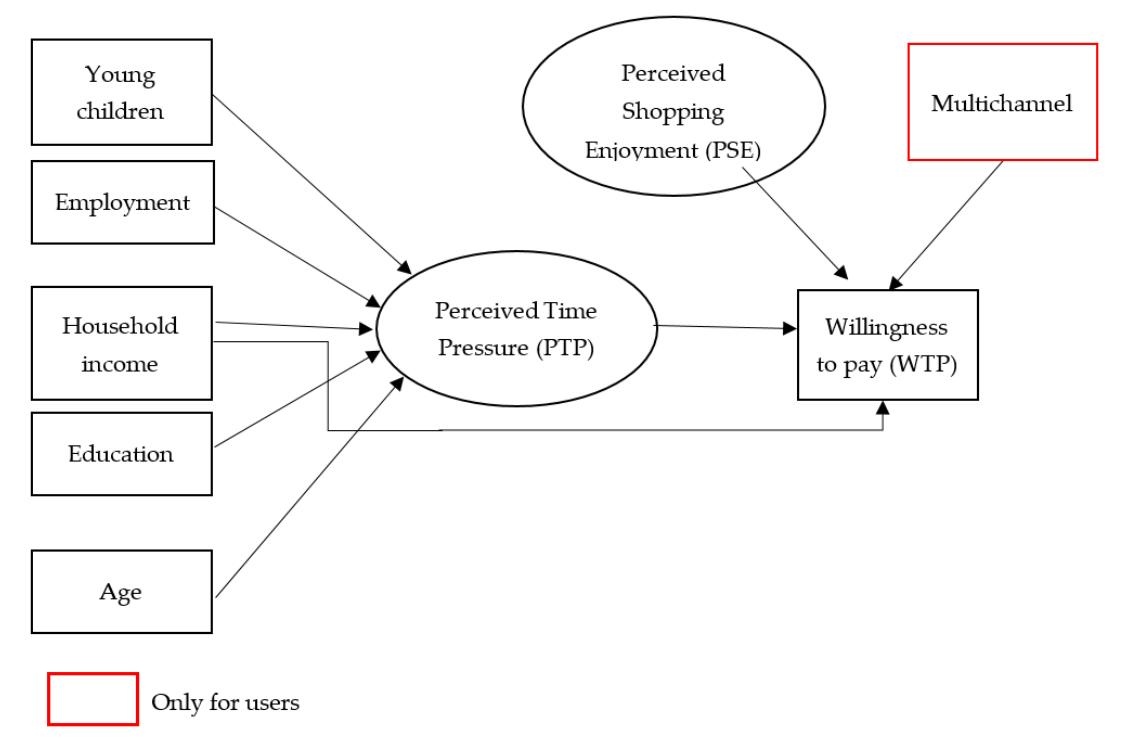
Figure 1. Conceptual model.